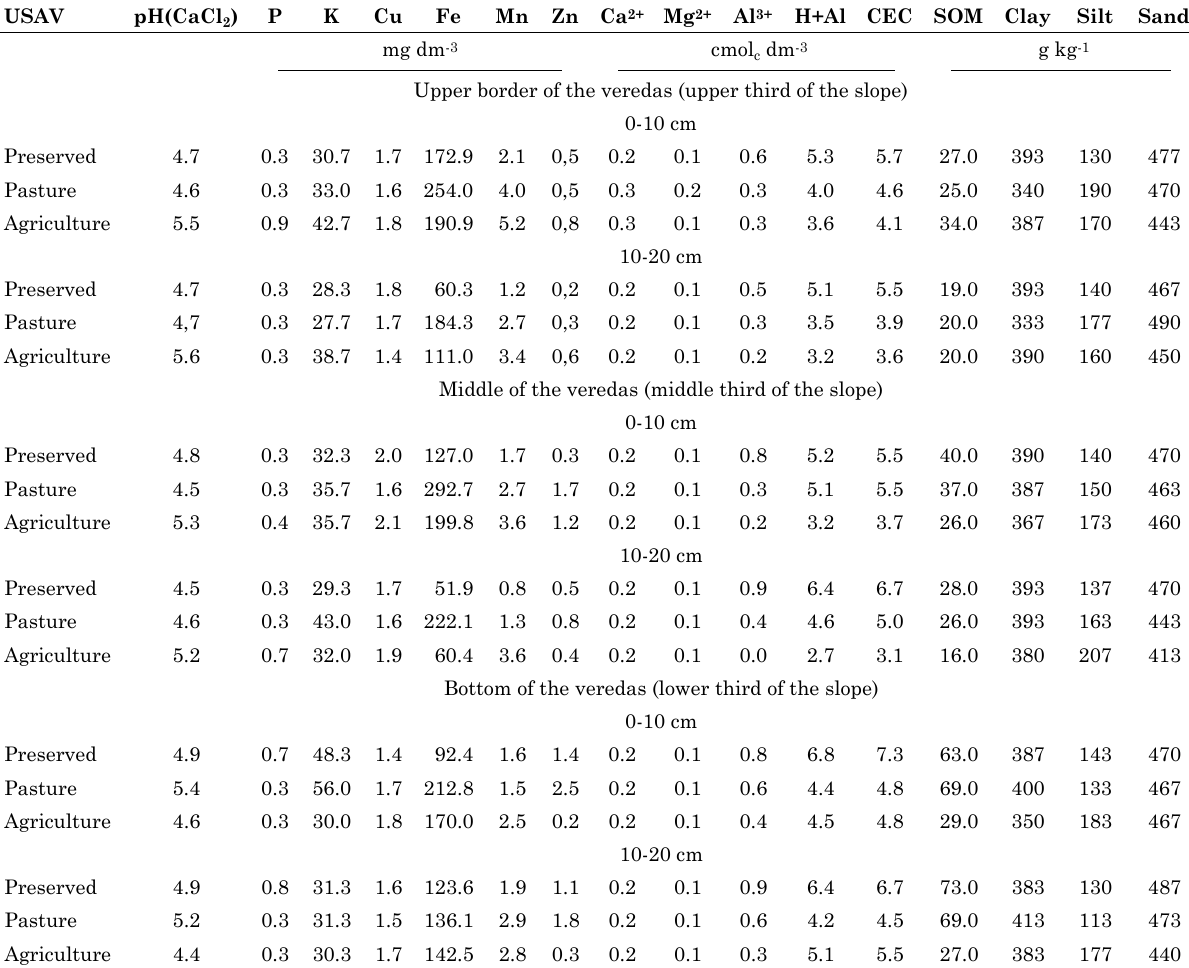
Table 1. Chemical properties and soil texture at different slope positions, layers (depths) of sampling and conditions of use of the surrounding areas of the veredas (USAV) USAV